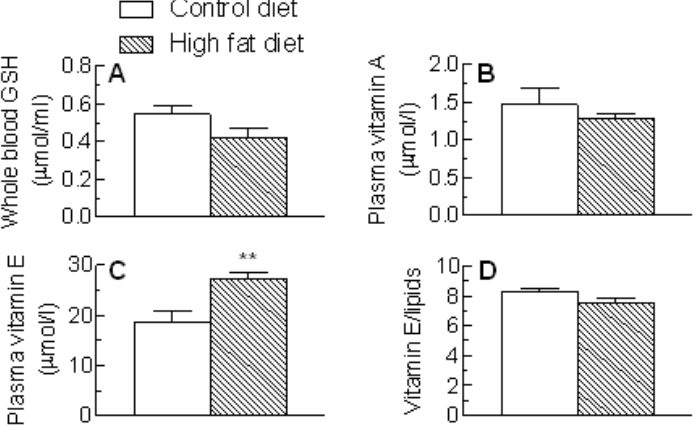
Figure 6. Plasma antioxidant levels in rats fed a standard low fat (Control diet) or a high fat diet for 18 weeks. Blood samples were collected and the concentrations of ( A ) Red blood cell glutathione (GSH) (data expressed as μmol/mL whole blood); ( B ) VitA; and ( C ) VitE were determined. ( D ) VitE/plasma lipids (μmol/mmol). Data for GSH are the mean from 7 (Control diet) or 9 (High fat diet) animals and those for vitamins A and E are the mean from 4 (control diet) or 6 (High fat diet) rats. Error bars show the SEM. ** P < 0.01 vs. Control